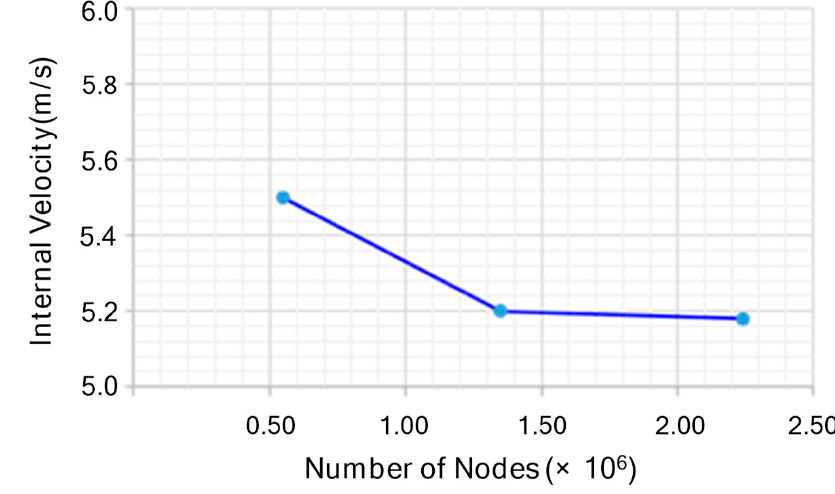
Figure 5. Grid dependency of flow at MCR.